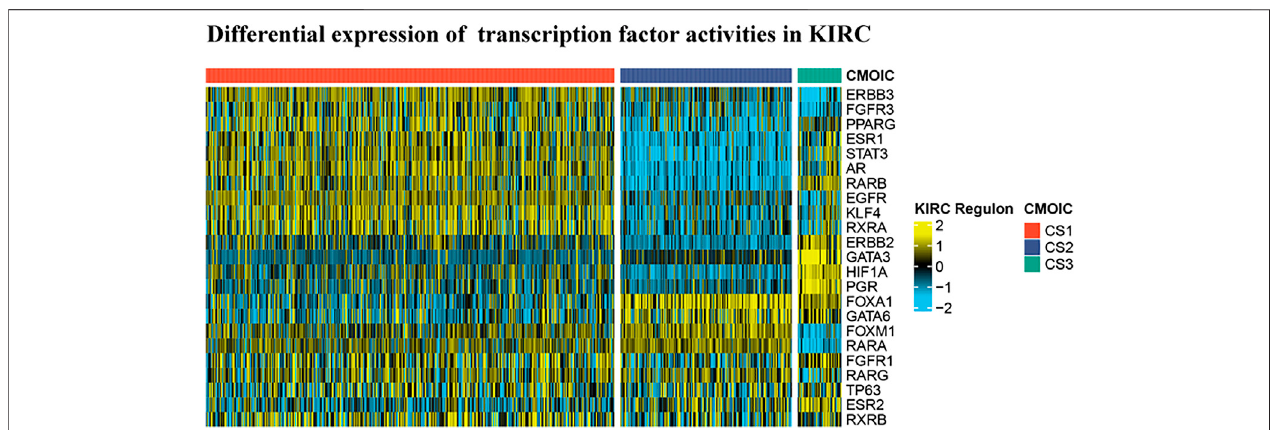
FIGURE 6 | Differential expression of 23 transcription factor activities in KIRC based on cluster analysis. Based on the previous cluster analysis, the KIRC samples were divided into three clusters according to active sphingolipid genes, inactive sphingolipid genes, and normal sphingolipid genes. By analyzing the expression of 23 transcription factors in the three clusters, it is evident that signi fi cant differences exist between the three clusters.